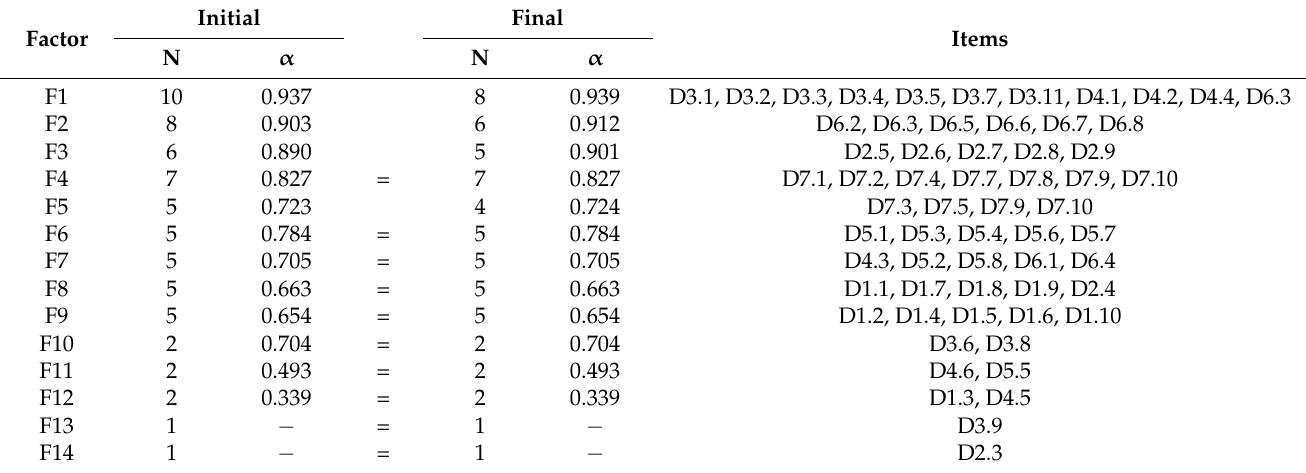
Table 4. Validation of FA through Cronbach’s alpha